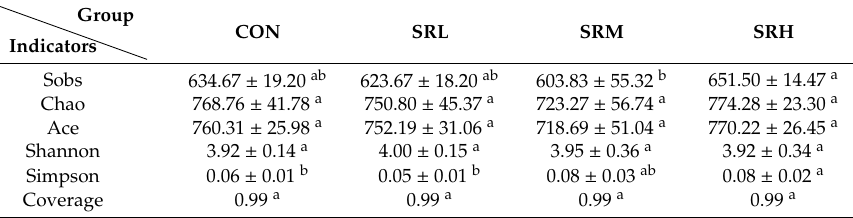
Table 6. Alpha diversity analysis.